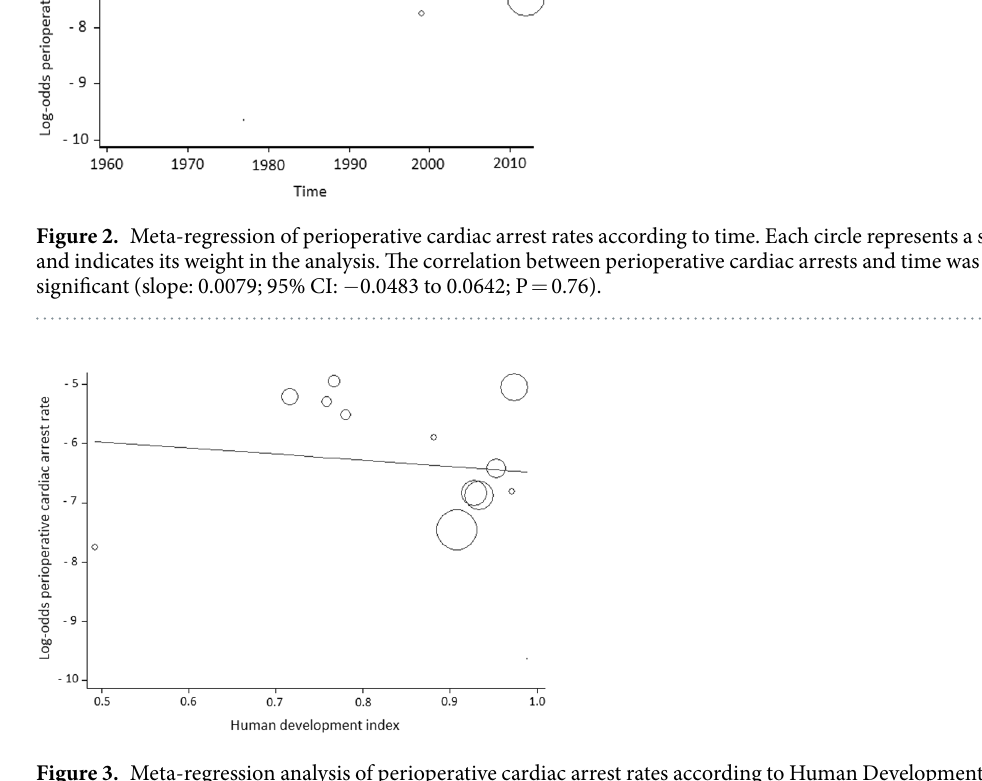
Figure 3. Meta-regression analysis of perioperative cardiac arrest rates according to Human Development Index (HDI) status. Each circle represents a study and indicates its weight in the analysis. The correlation between perioperative cardiac arrests and HDI was not significant (slope: − 1.0389; 95% CI: − 6.7380 to 4.6601; P =